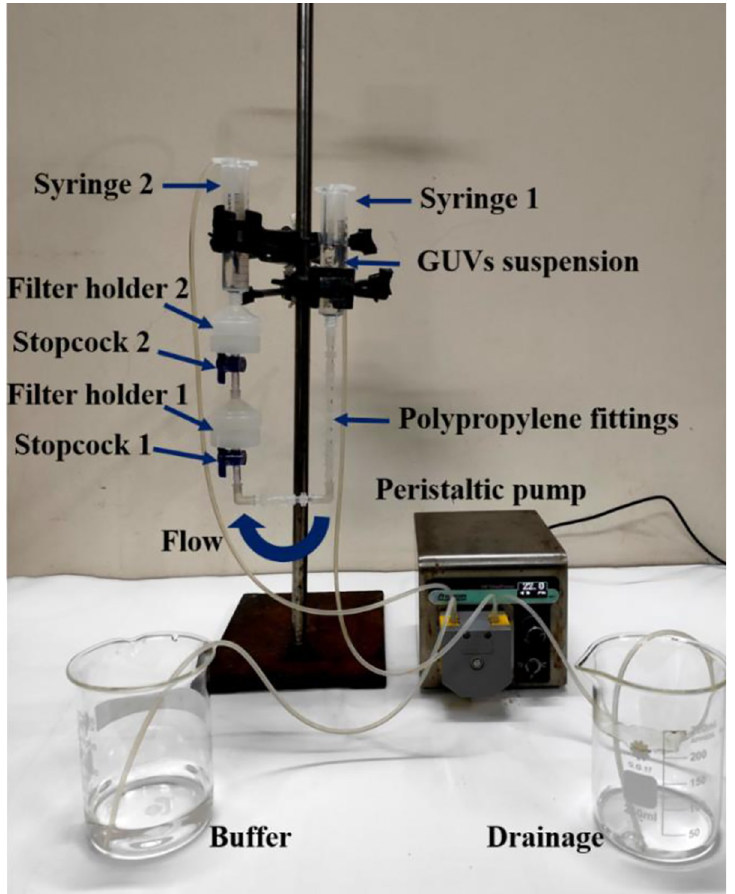
Fig 2. Experimental set-up of dual filtration